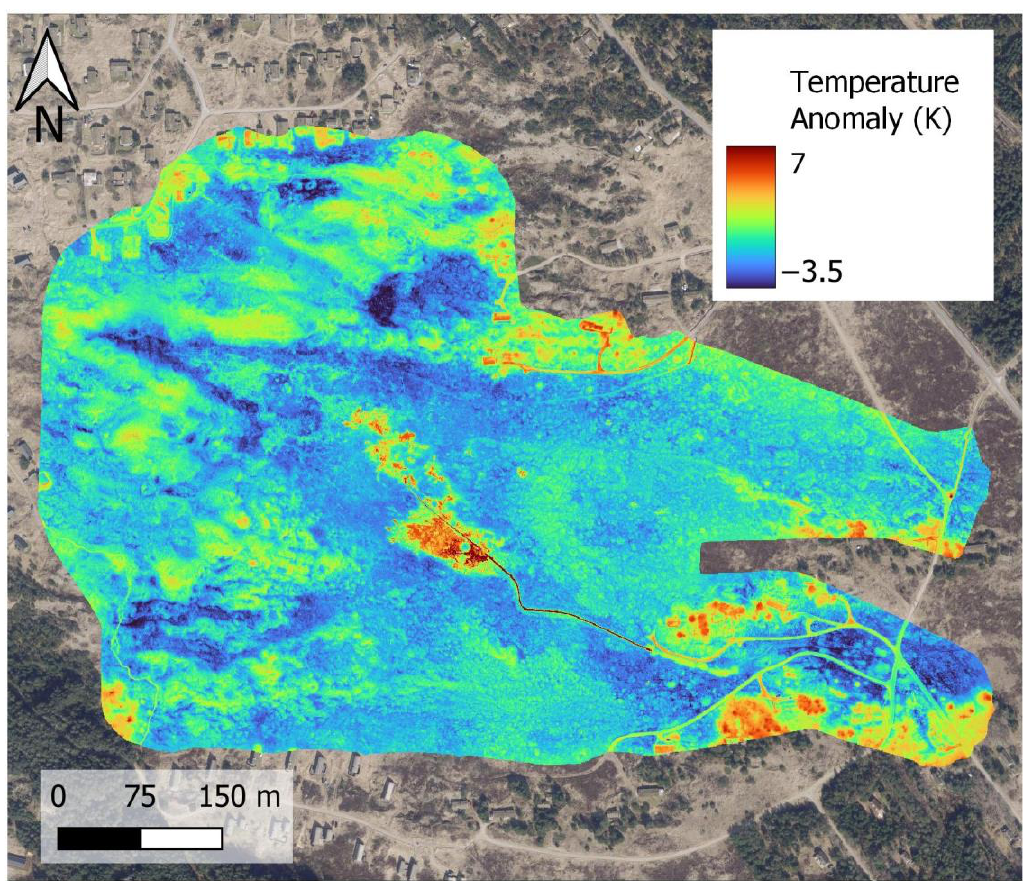
Figure 3. Thermal anomaly map (in Kelvin) for the Rødehus Kanal area. Temperature anomaly is defined as temperature at each pixel minus average temperature of the scene.